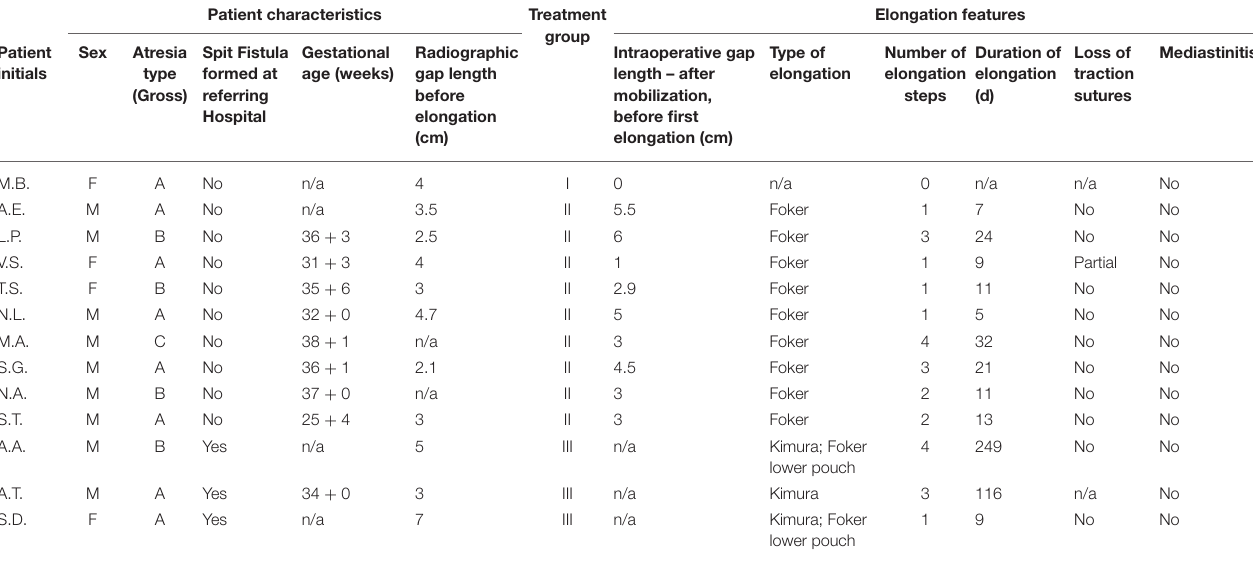
TABLE 1 | Patient characteristics and features describing the course of the elongation procedures.